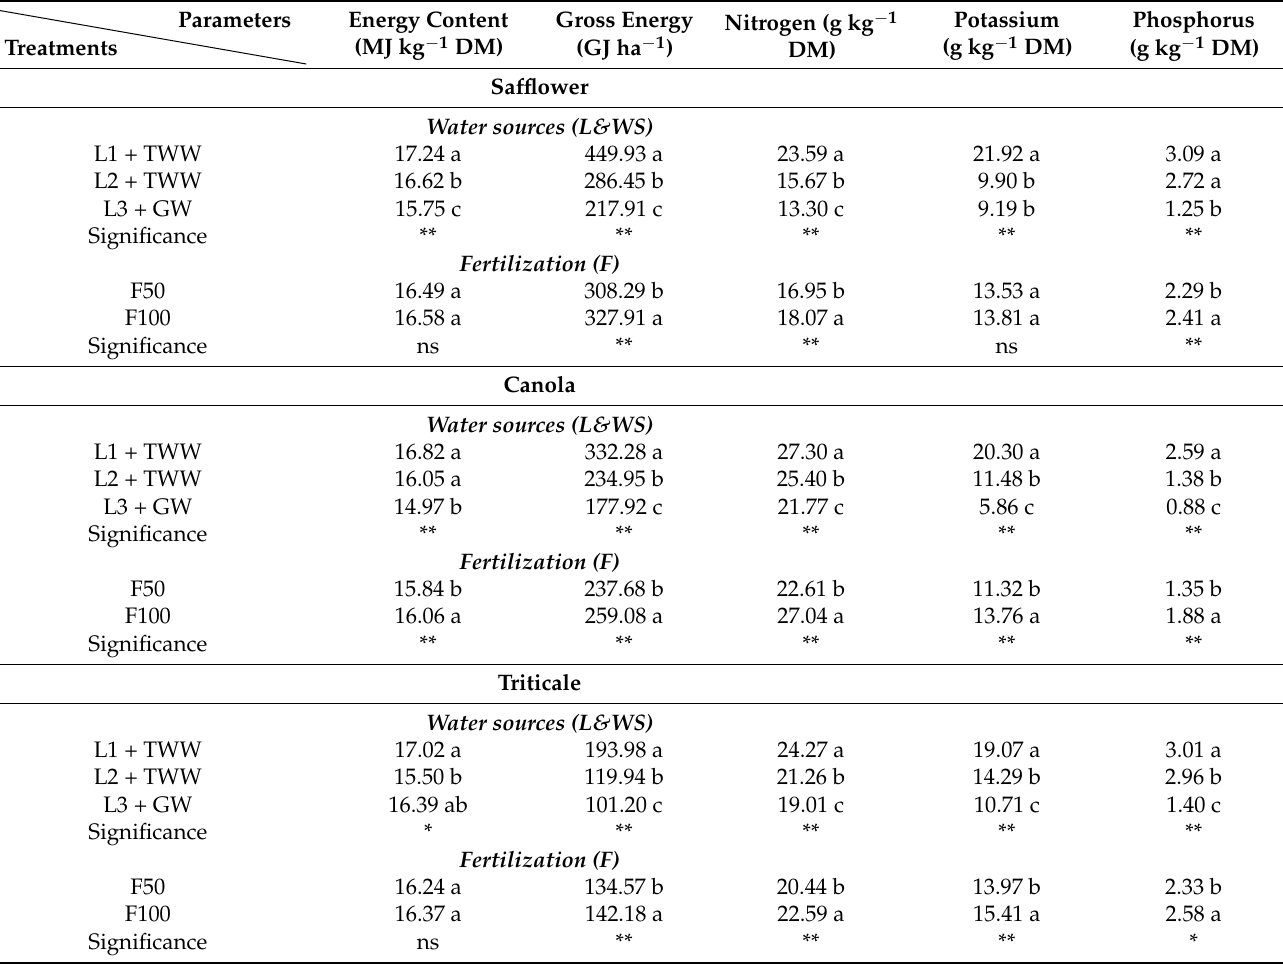
Table 5. Effects of individual factors of water resources and fertilization treatments on macro-elements content and energy traits of safflower, canola, and